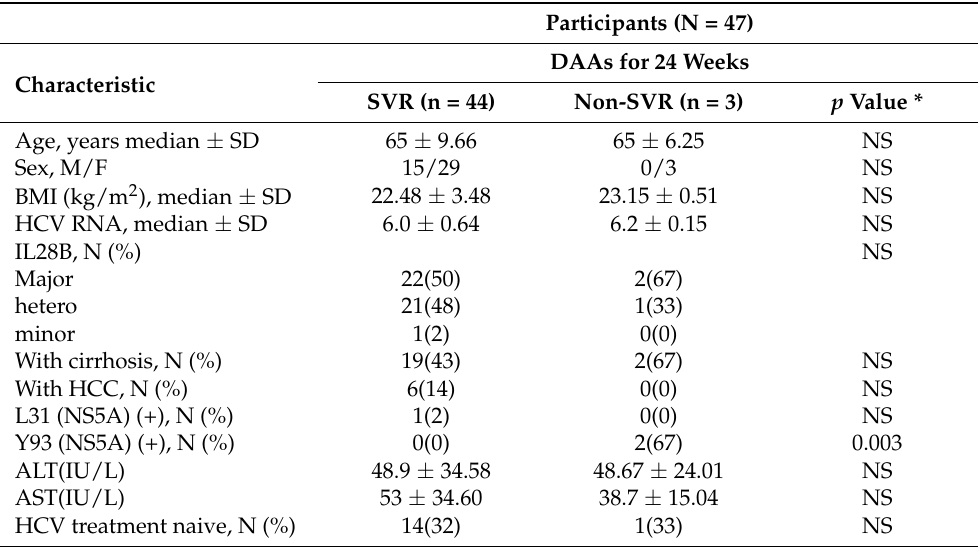
Table 1. Clinical characteristics of HCV-infected patients before treatment with DAAs.